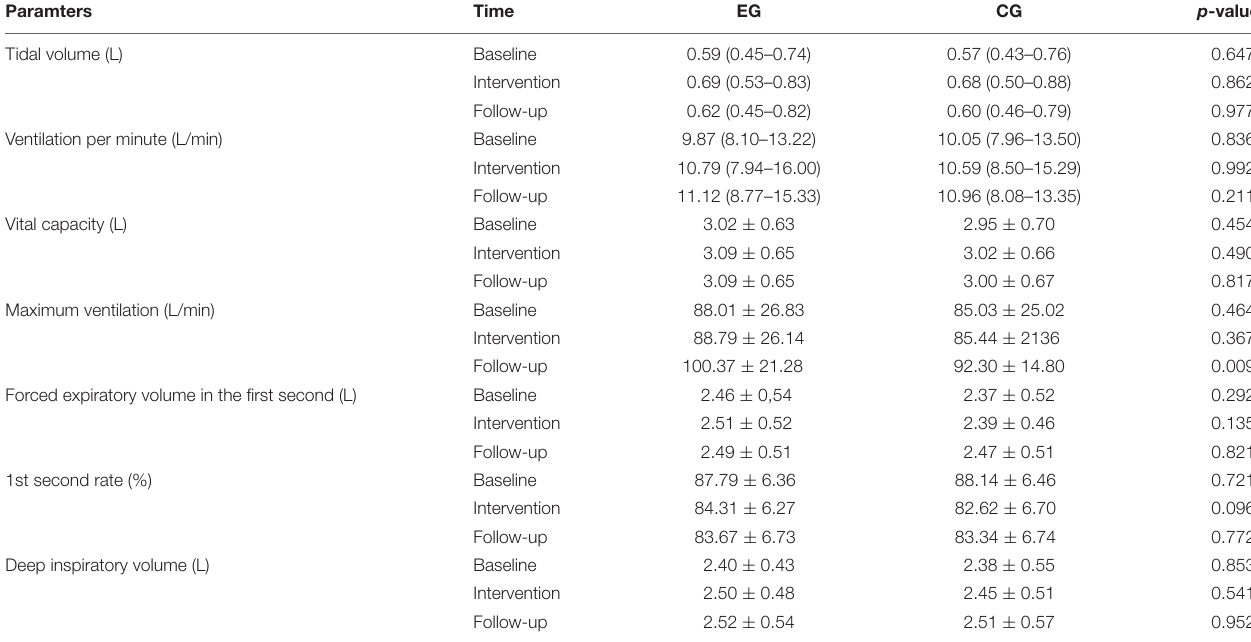
TABLE 3 | The effects of eight-section brocades exercise on lung function.